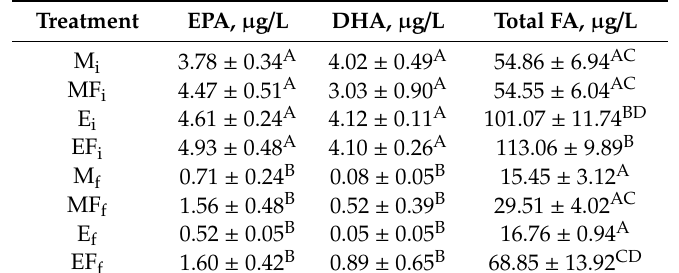
Table 2. Results of one-way ANOVA comparing means ( ± SE) of concentrations of indicators of nutritive quality of seston in experimental mesocosms: EPA—eicosapentaenoic acid, DHA—docosahexaenoic